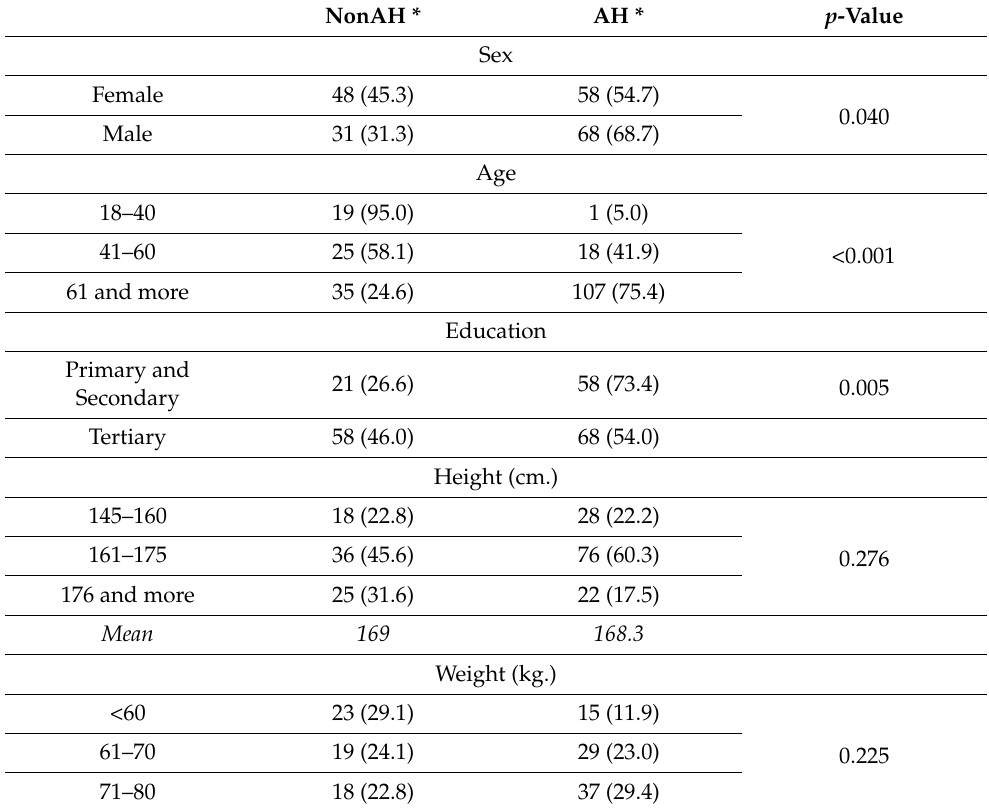
Table 2. Sociodemographic characteristics of the respondents divided into non-hypertensive and hypertensive subjects (N =